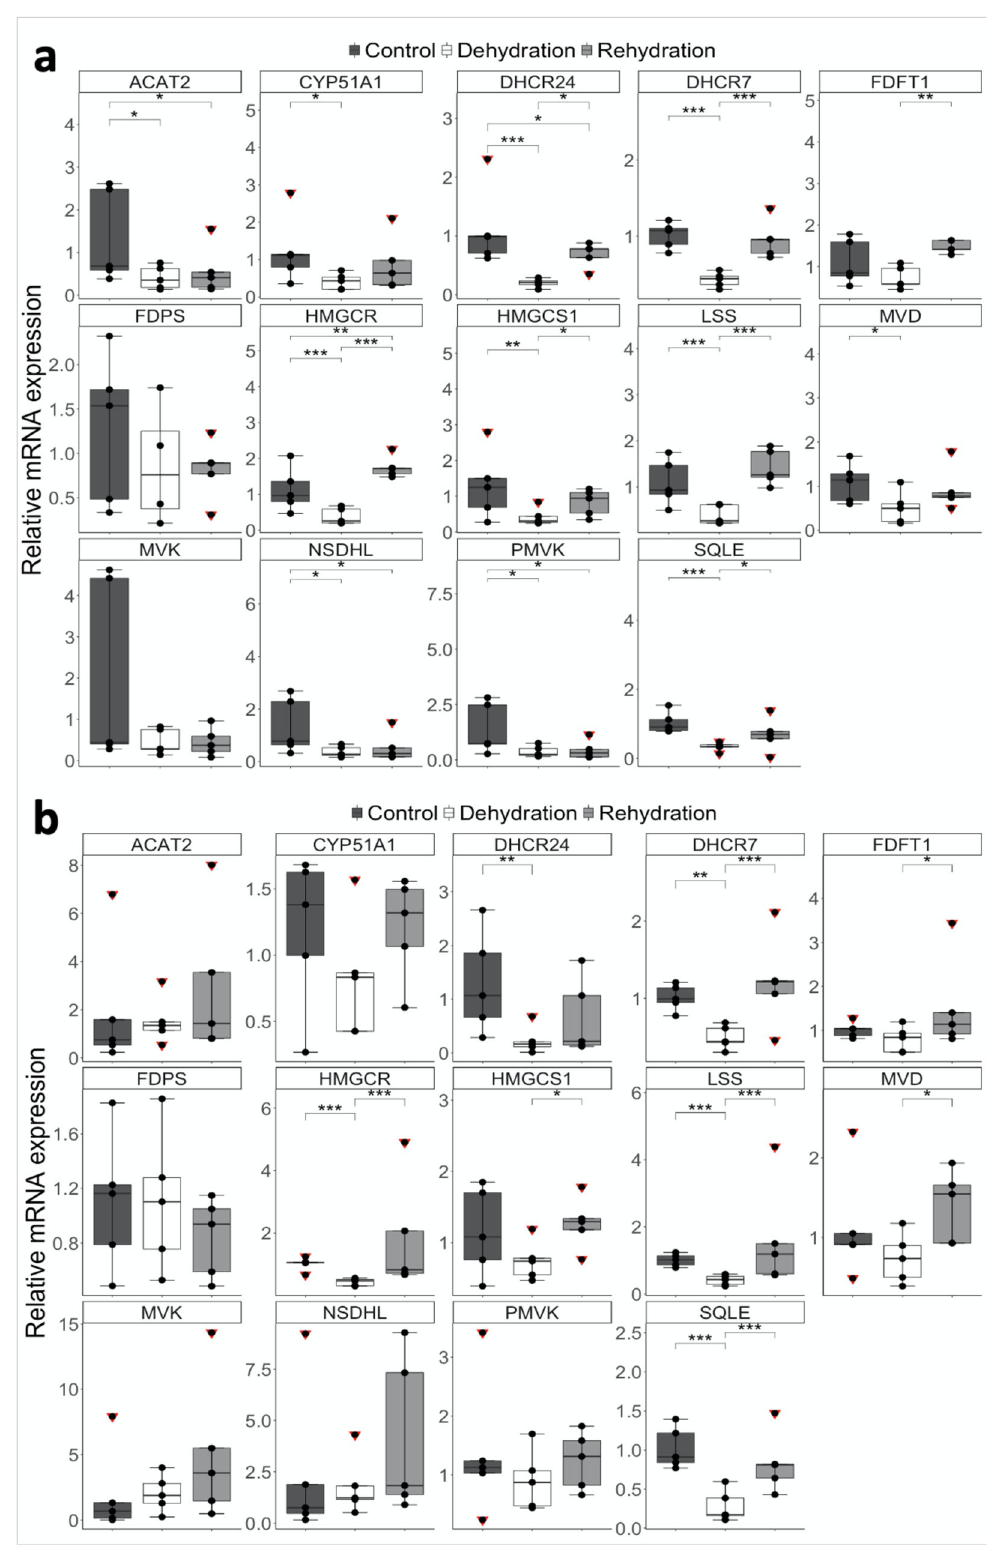
Fig. 5 RT-qPCR validation of genes coding for enzymes involved in the cholesterol biosynthetic process. Relative changes in gene expression of genes involved in cholesterol synthesis in the Arabian camel kidney a medulla and b cortex after severe dehydration and acute rehydration compared to controls. Comparison of the means by one-way ANOVA (Turkey ’ s post hoc correction). The boxplots are presented with the S.E.M. ( n = 5), centre lines show median, box edges delineate 25th and 75th percentiles and bars extend to minimum and maximum values. Individual data points represent biologically independent samples and data points within red triangles denote outliers, all the outliers highlighted were included for the statistical analyses. *** p adj < 0.001, ** p adj < 0.01, * p adj <